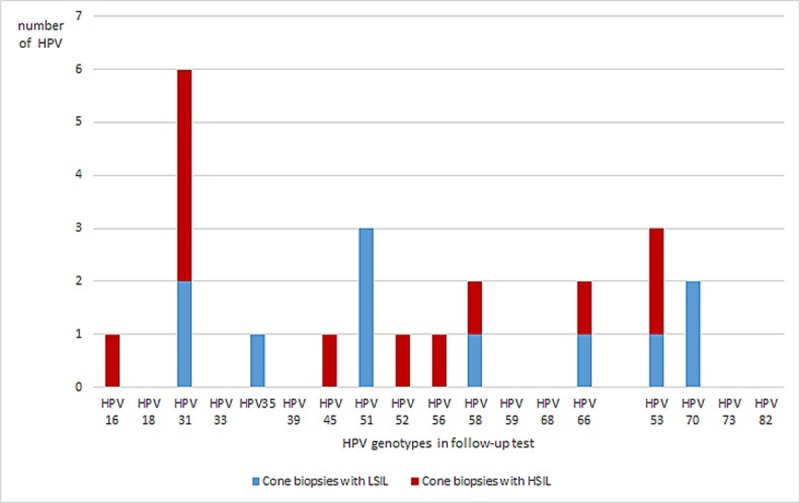
Distribution of hrHPV genotypes in the follow-up test, among the patients with ≥LSIL.Follow-up test showed multi-infection prior to six of the cones, and nine women were cleared from hrHPV at follow-up before cone biopsy.